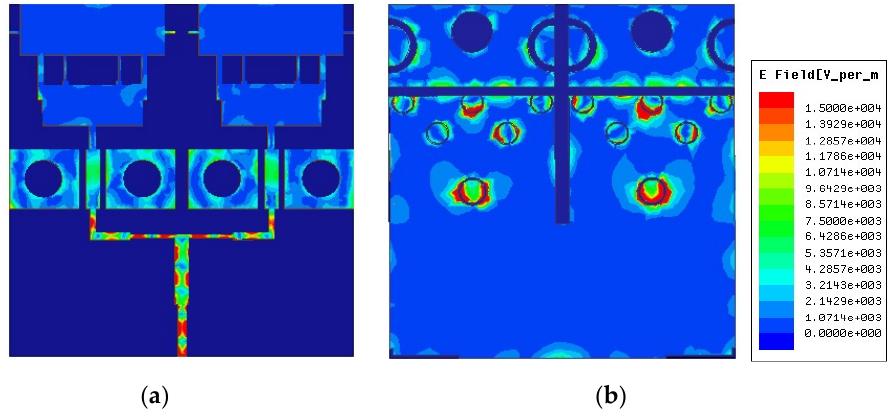
Figure 16. Simulated radiation characteristics of a single antenna ( a ) 2-D radiation pattern; ( b ) 3-D radiation pattern.